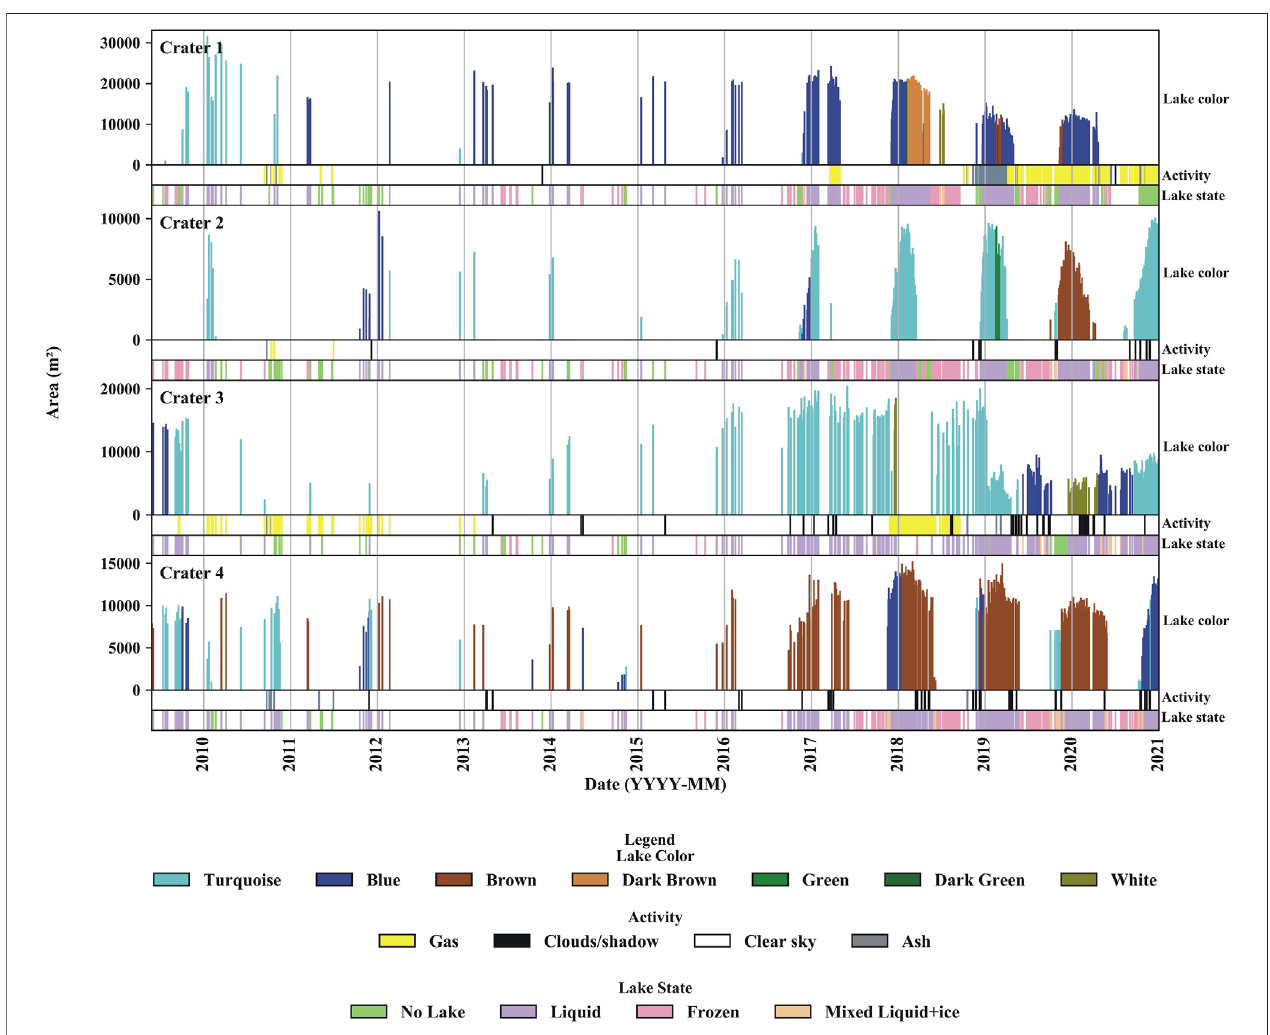
FIGURE 6 | Area in m 2 vs. date (YYYY-MM) is shown for Crater Lakes 1, 2, 3, and 4. The secondary graphics at the base of main graphics showed the lake color, super fi cial atmospheric/volcanic activity over the crater lakes (presence of gas, clouds or shadow, and ash over crater; white areas correspond to clear sky), and lake state (liquid, frozen, or mixed liquid +